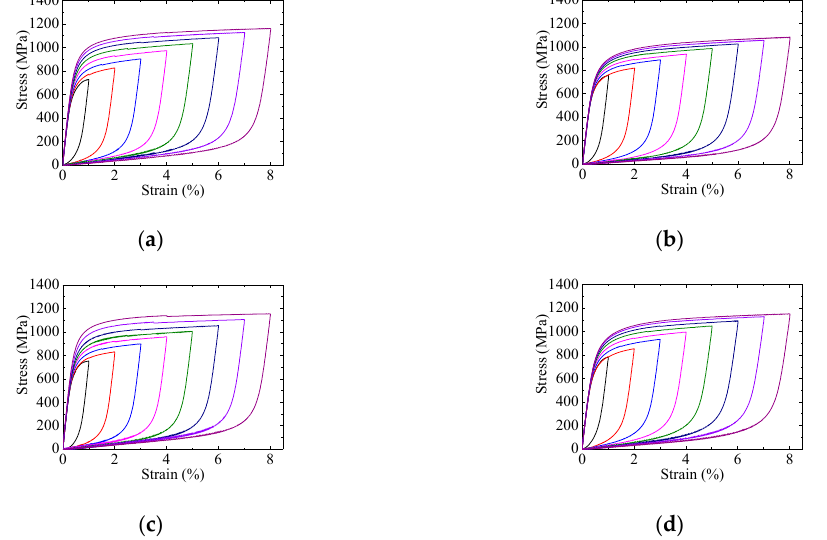
Figure 16. Relative hysteretic curves of Q345. ( a ) S ‐ NT; ( b ) S ‐ 900 ‐ 1; ( c ) S ‐ 900 ‐ 2; ( d ) S ‐ 900 ‐ 3.